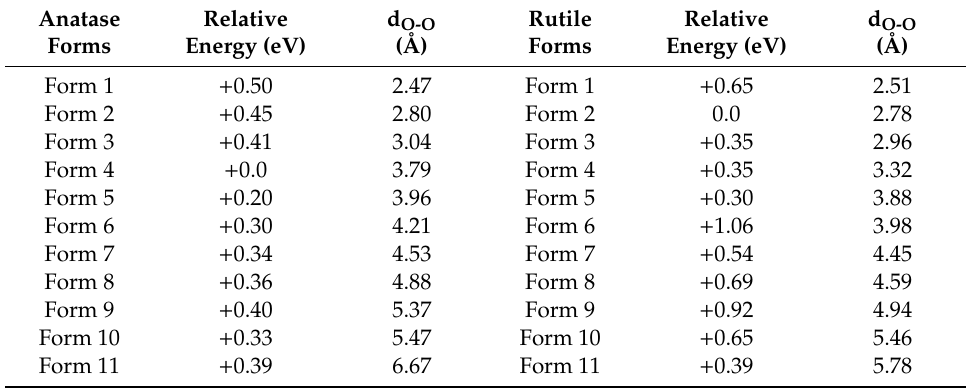
Table 1. Relative energies and O-O-vacancy distances for di ff erent forms of double O-vacancy rutile and anatase TiO 2